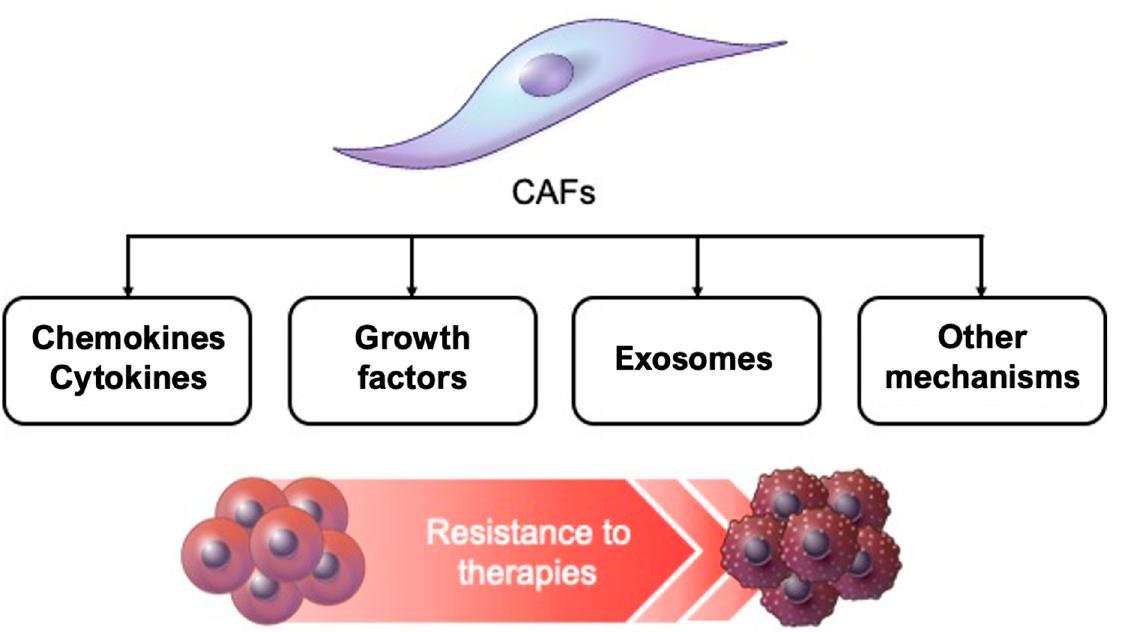
Figure 3. Cancer-associated fibroblasts (CAFs) orchestrate the resistance to chemoradiotherapies in the tumor microenvironment. CAFs secrete abundant chemokines, cytokines, growth factors, exosomes, and other factors. Table 2. Cancer-associated fibroblast (CAF)-derived factors that can induce treatment resistance in gastrointestinal cancers. CAF-Derived